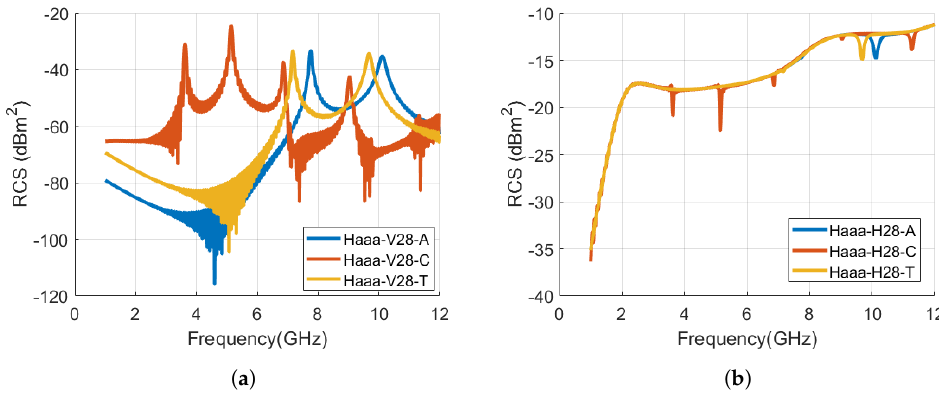
Figure 14. Comparison of RCS results of alphabet Ł tag with various font types (Arial, Calibri, and Times New Roman) with the font size of 28: ( a ) Vertical polarization; ( b ) Horizontal polarization. Table 4. Signature resonance frequencies for tag letter Ł with various font types (Arial, Calibri and Times New Roman) with the font size of 28.